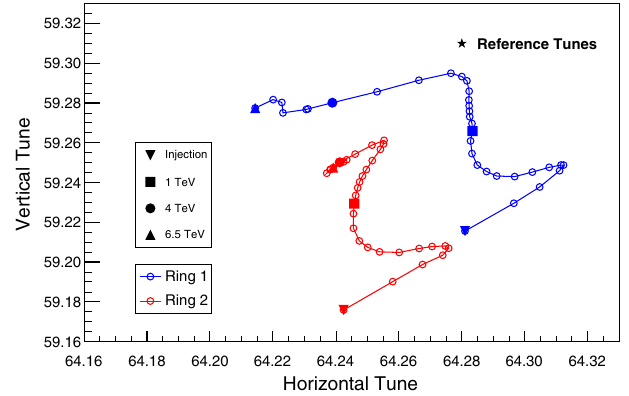
FIG. 5. Evolution of the bare machine tunes (before any correction) along the cycle from injection to 6 . 5 TeV = c at constant optics.